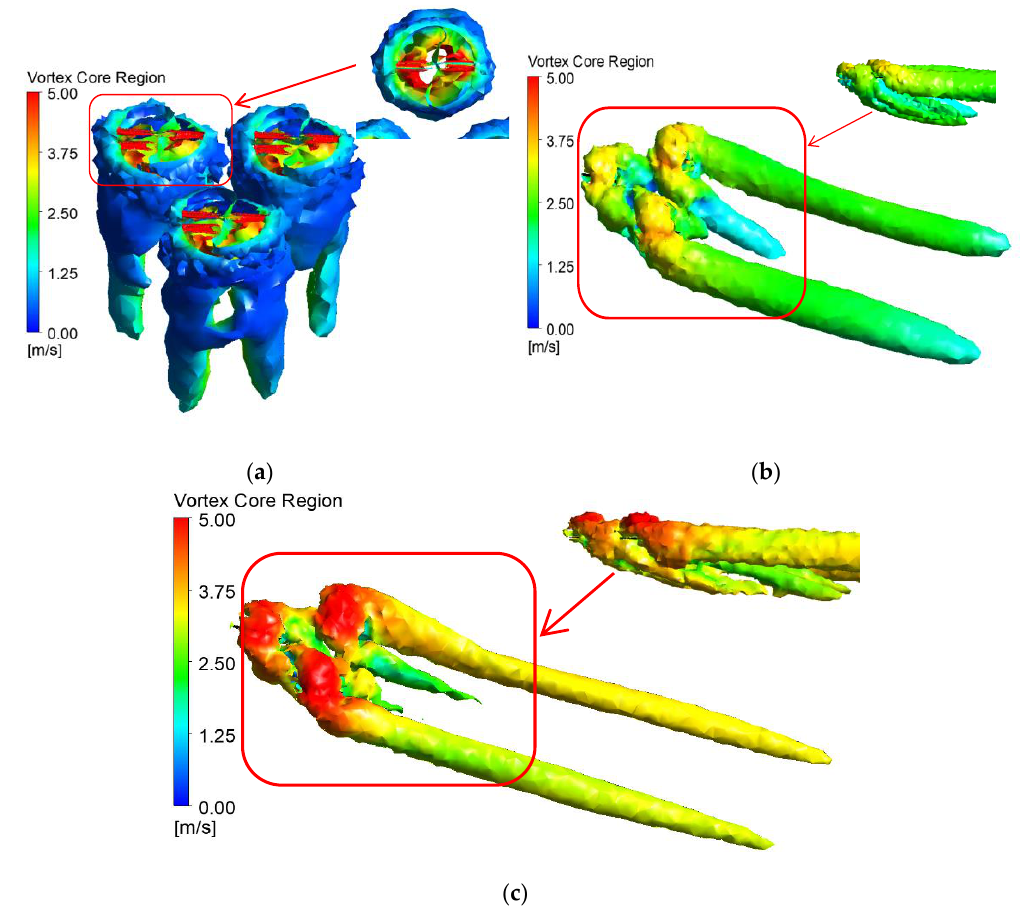
Figure 11. The vortex distribution of the coaxial Tri-rotor (2200 r / min): ( a ) 0 m / s; ( b ) 2.5 m / s; ( c ) 4 m /